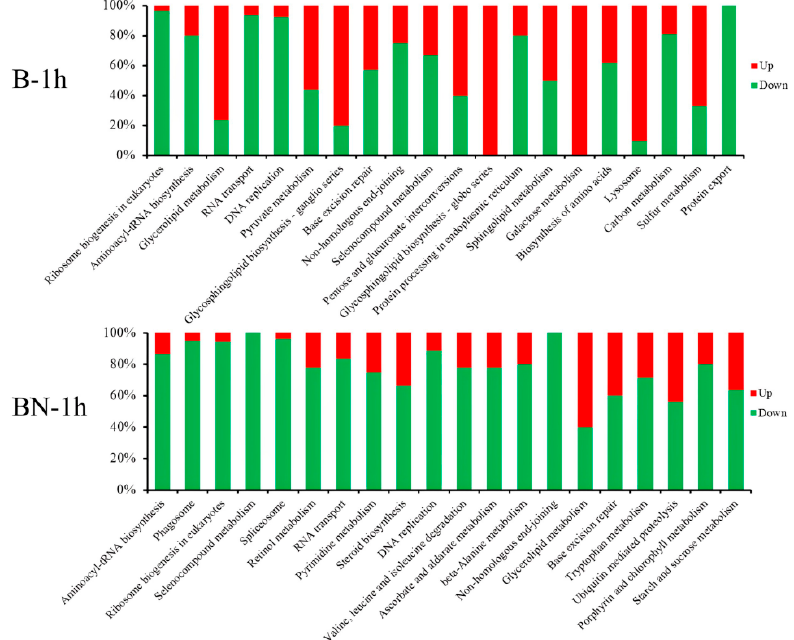
Figure 5. Percentage of up- or downregulated DEGs among different KEGG pathways in B-1h and BN-1h.